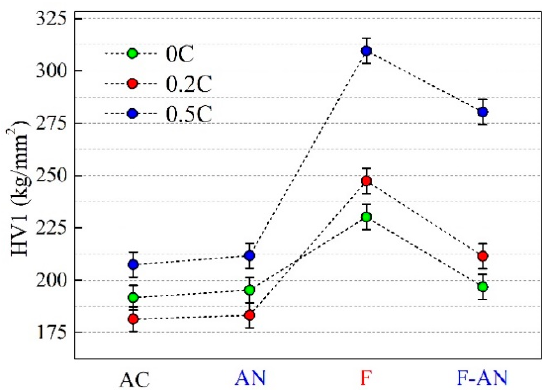
Figure 9. Hardness distribution of the specimens with different carbon contents under different heat treatment states.